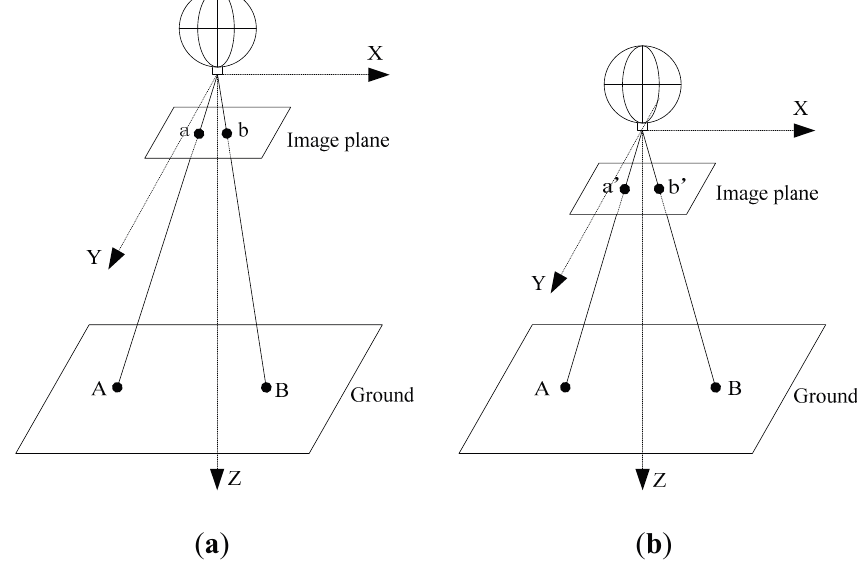
Figure 2. The monocular vision model and coordinate system